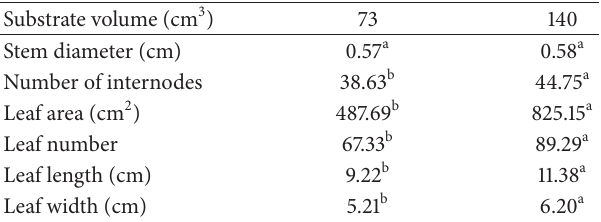
Table 3: Effect of substrate volumes on shoot growth of chrysanthe- mum.